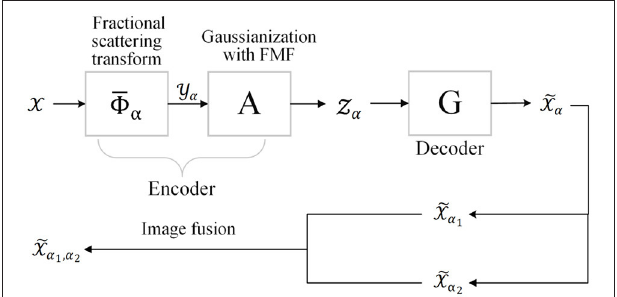
FIGURE 2 | Structure of generative fractional scattering networks